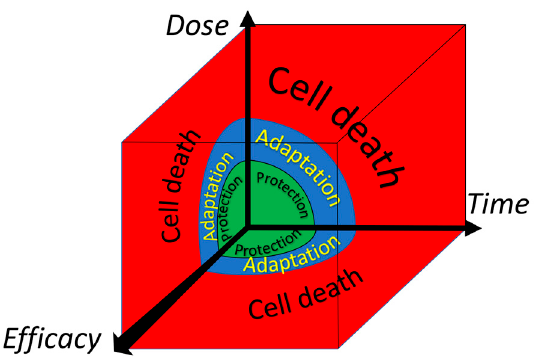
Figure 6. The dependence of the acute adaptive response of the cell to a toxic compound on the dose of the compound, on the efficacy of the compound and on time. Adapted from Sthijns et al. [68]. Adaptation due to switching on redox-sensitive master switches takes several hours.